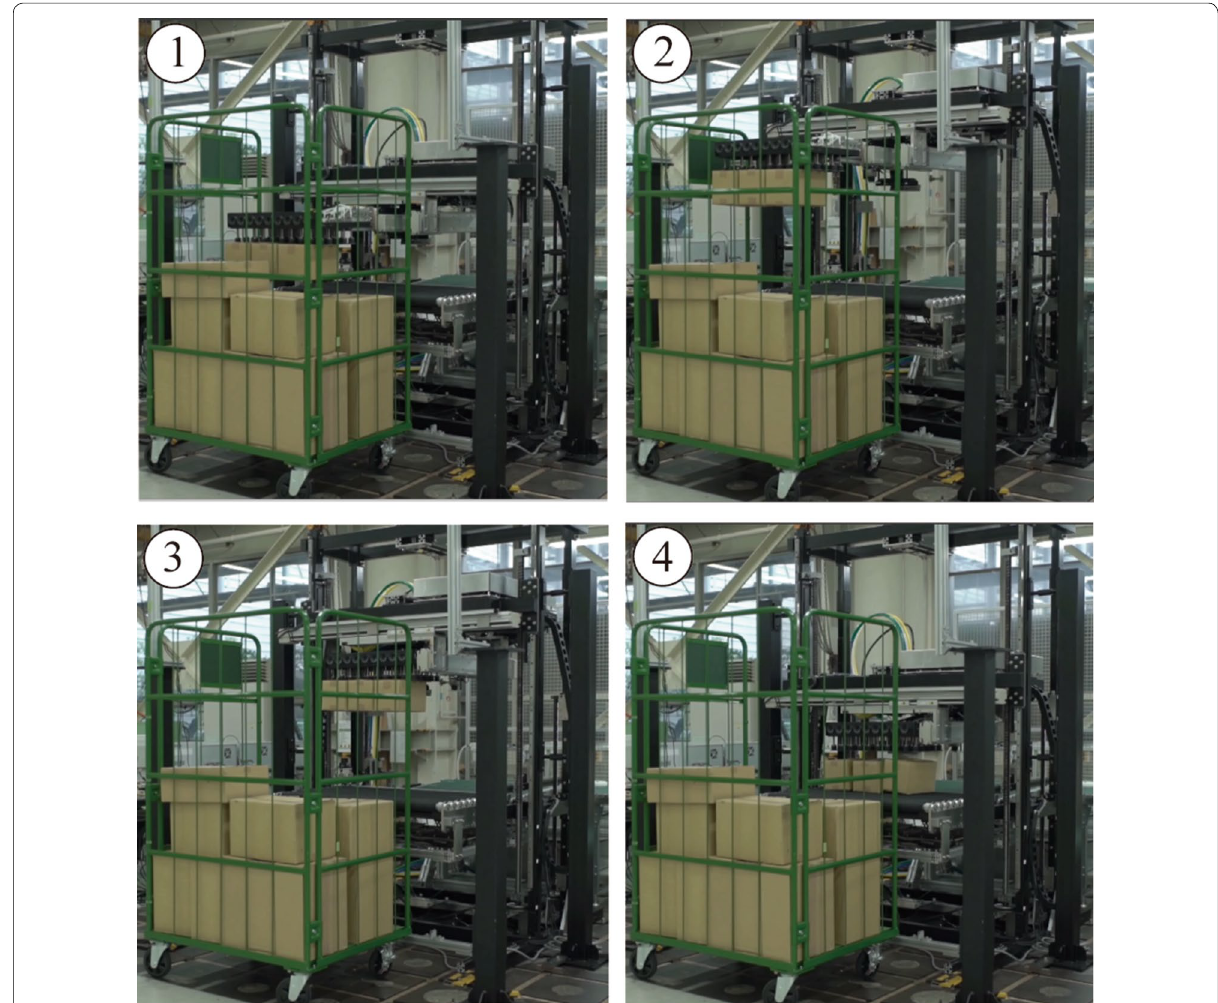
Fig. 4 Unloading operation by a conventional linear motion-type depalletizing robot